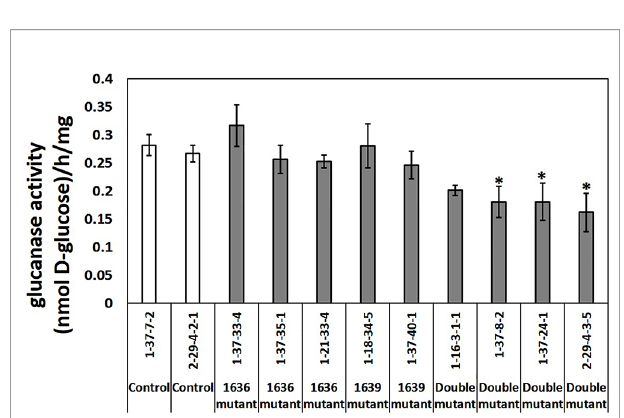
FIGURE 7 | Total b -1,3-glucanase activities (mean ± SE, n=4 or 5) in crude protein extracts of seedlings from two control lines, fi ve single and four double mutant barley lines. The data was analyzed by one-way ANOVA (see Table S1 ), followed by LSD test at p =0.05. * above the bar indicate signi fi cant differences between the mutant line and both control